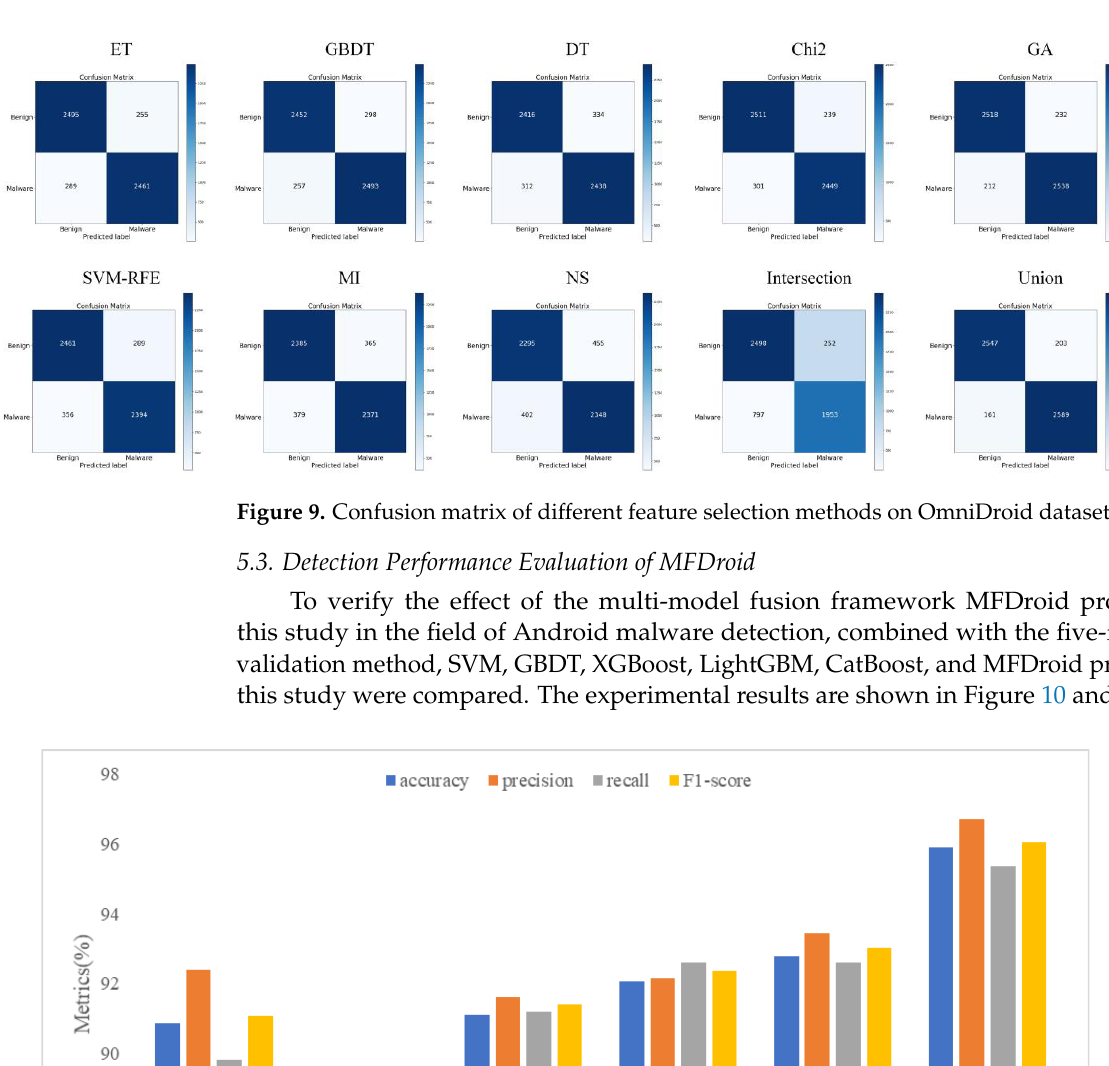
Figure 8. ROC curves of different feature selection methods on OmniDroid dataset.